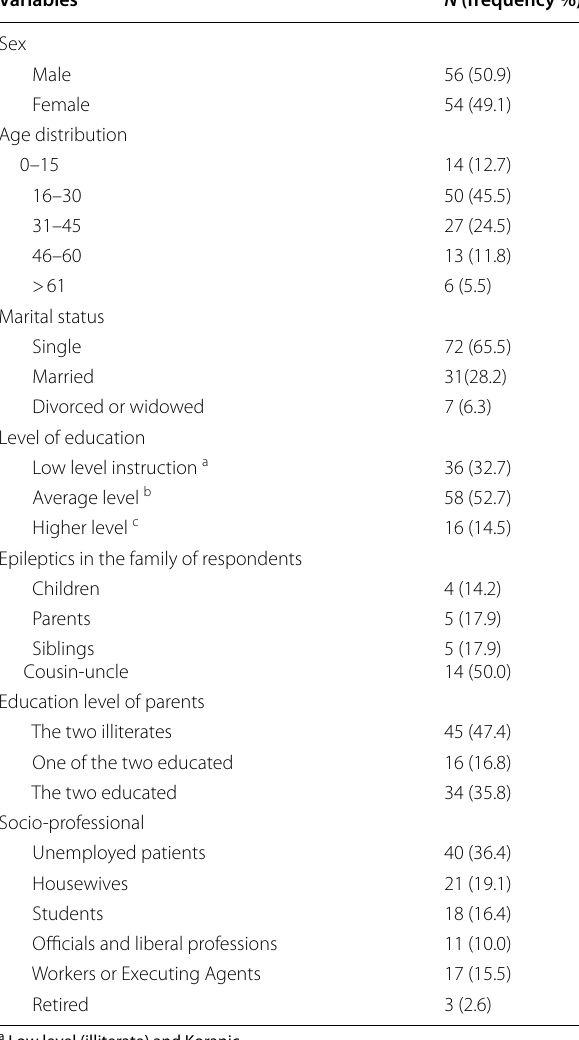
Table 1 Demographic and socio-cultural characteristics of patients with epilepsy ( N 110) =